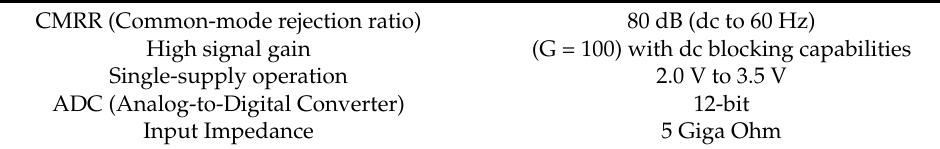
Table 1. The BC1 device